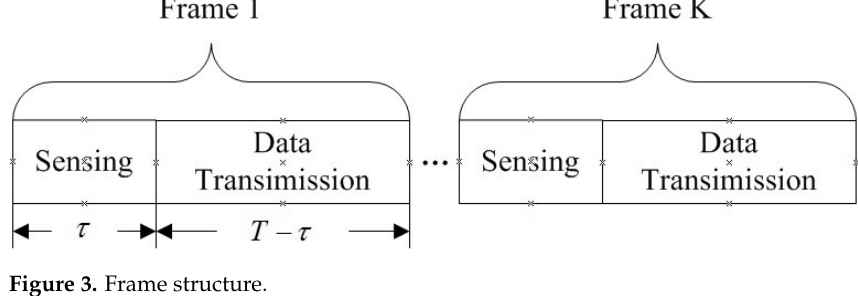
Figure 3. Frame structure.